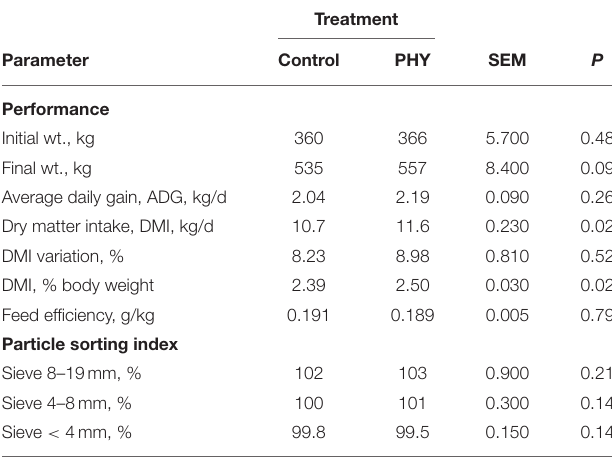
TABLE 6 | Comparison of overall trial dry matter intake, average daily gain and particle sorting index, and apparent total tract digestibility of crossbred finishing bulls from day 8 to